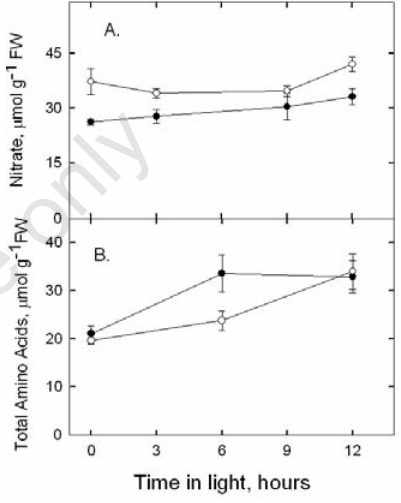
Figure 1. Effects of CO enrichment on 2 components of soybean trifoliolates. Inorganic nitrate (panel A) and total solu- ble amino acids (panel B) were determined at indicated times using the central lobe of the third trifoliolate leaf of 25 day old plants from the ambient ( ° ) and the ele- vated ( l ) CO treatments. Results are 2 means ± SE for two replicate experiments with five leaflets per time point from each